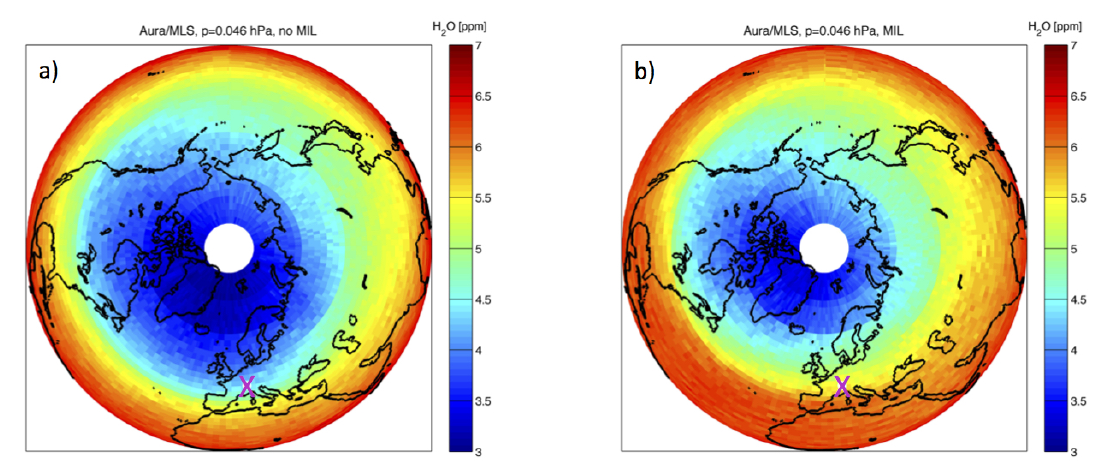
Figure 8. Polar plots of mesospheric water vapour at p = 0.046 hPa (at cold base of MIL and at peak of water vapour change at Bern) observed by Aura/MLS during winter: ( a ) composite when “no MIL” was above Bern; ( b ) composite when an “MIL” was above Bern. The location of Bern is indicated by the magenta